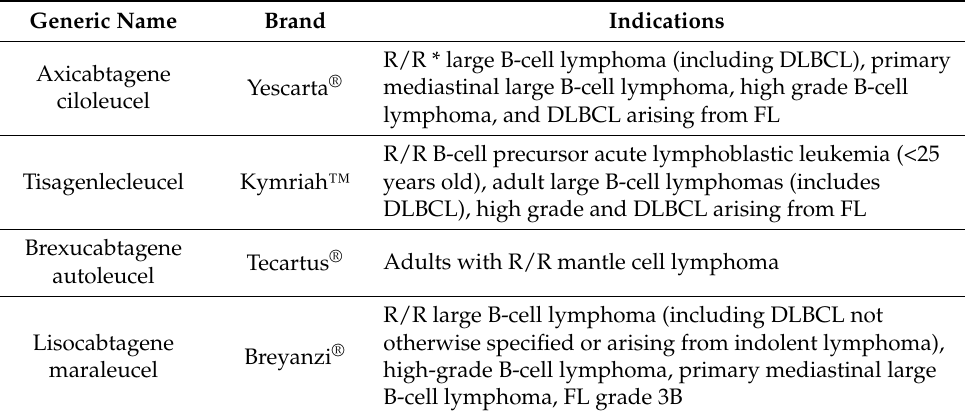
Table 2. FDA-approved CAR T cell therapies as of 10 March 2021. * R/R: refractory or